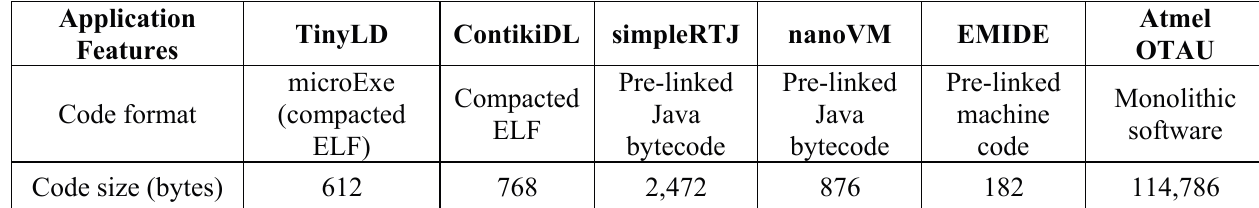
Table 8. Comparison of the reprogramming code sizes in the different mechanisms.